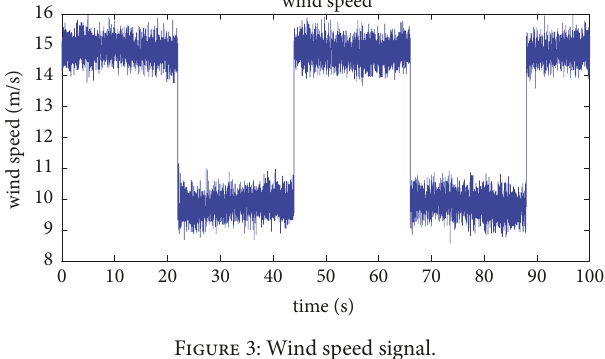
Figure 3: Wind speed signal.